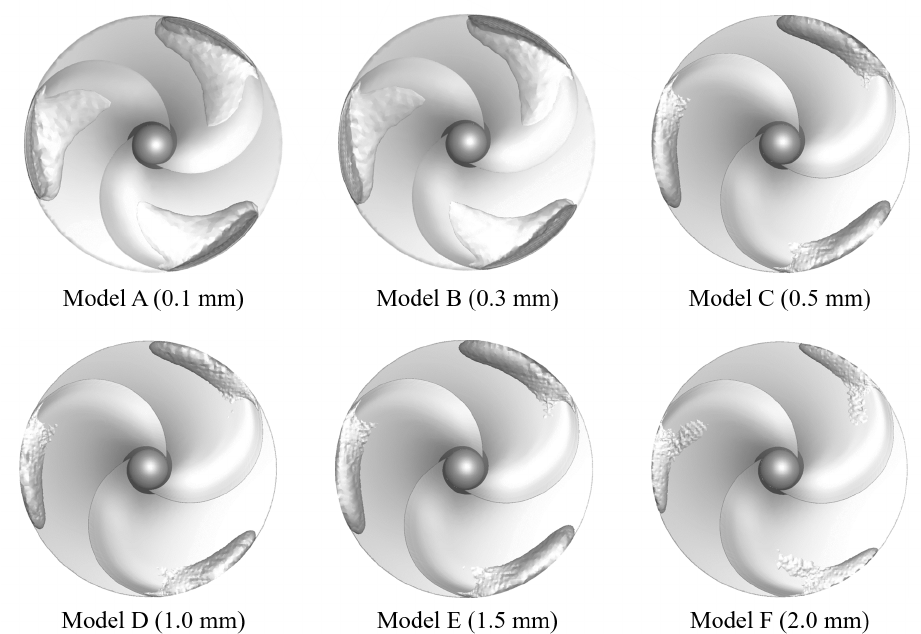
Figure 10. A typical instant of cavity structures at a vapor volume fraction of 0.3 for all six